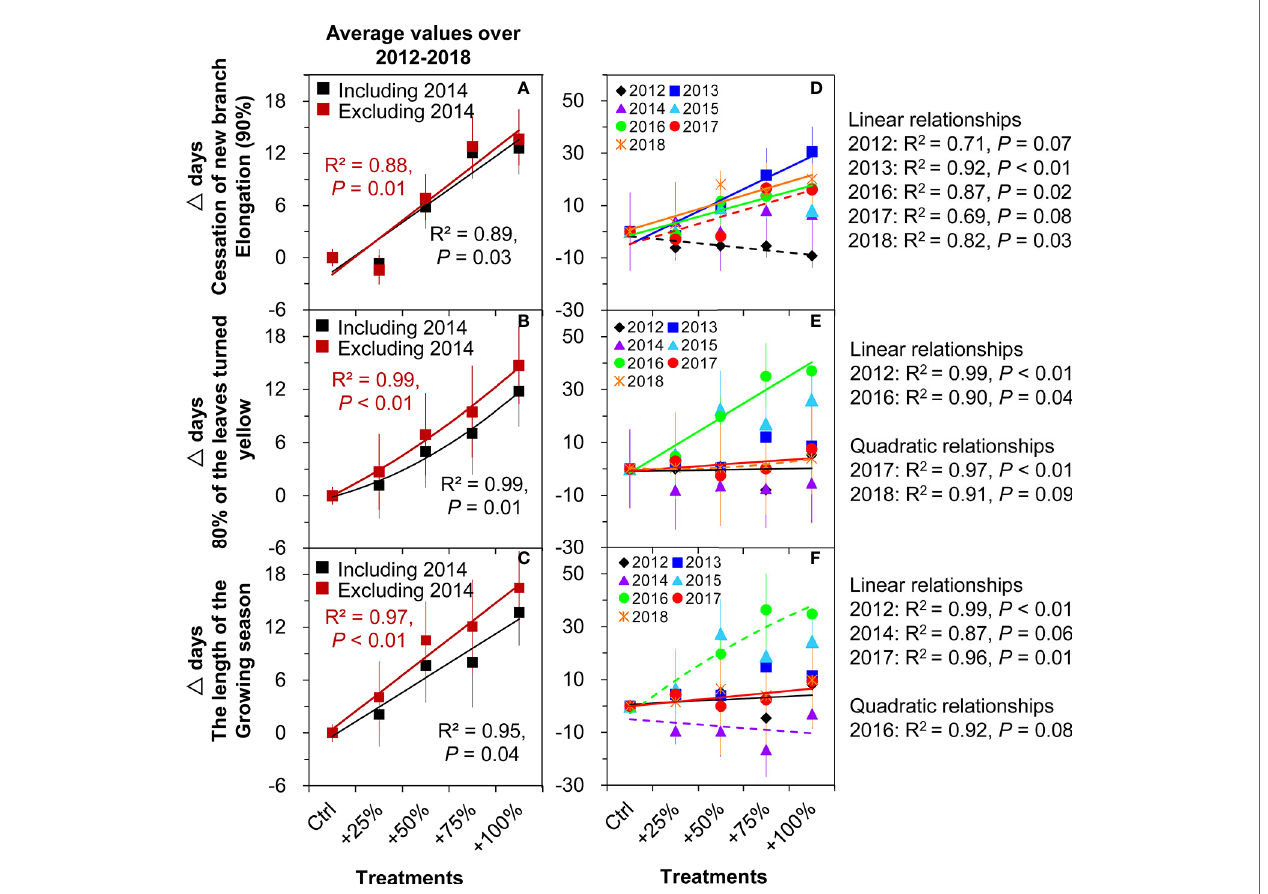
FIGURE 7 | Correlations between the amount of water addition (Ctrl), +25, +50, and +100%) and the changes ( △ days) of the phenological events of N. tangutorum . The solid lines indicate P ≤ 0.05, and the dashed lines indicate 0.05< P < 0.1. A, D represent cessation of new branch elongation. B, E represent 80% of the leaves turned yellow. C, F represent the length of the growing